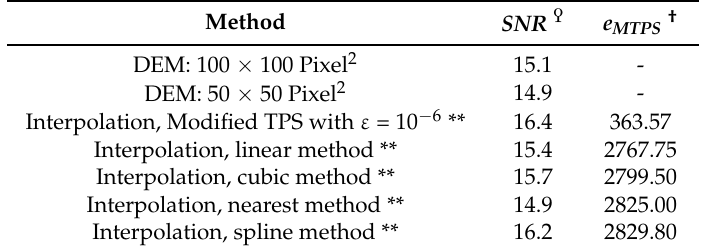
Table 280: teubner Archaic Greek Letters and Greek Numerals